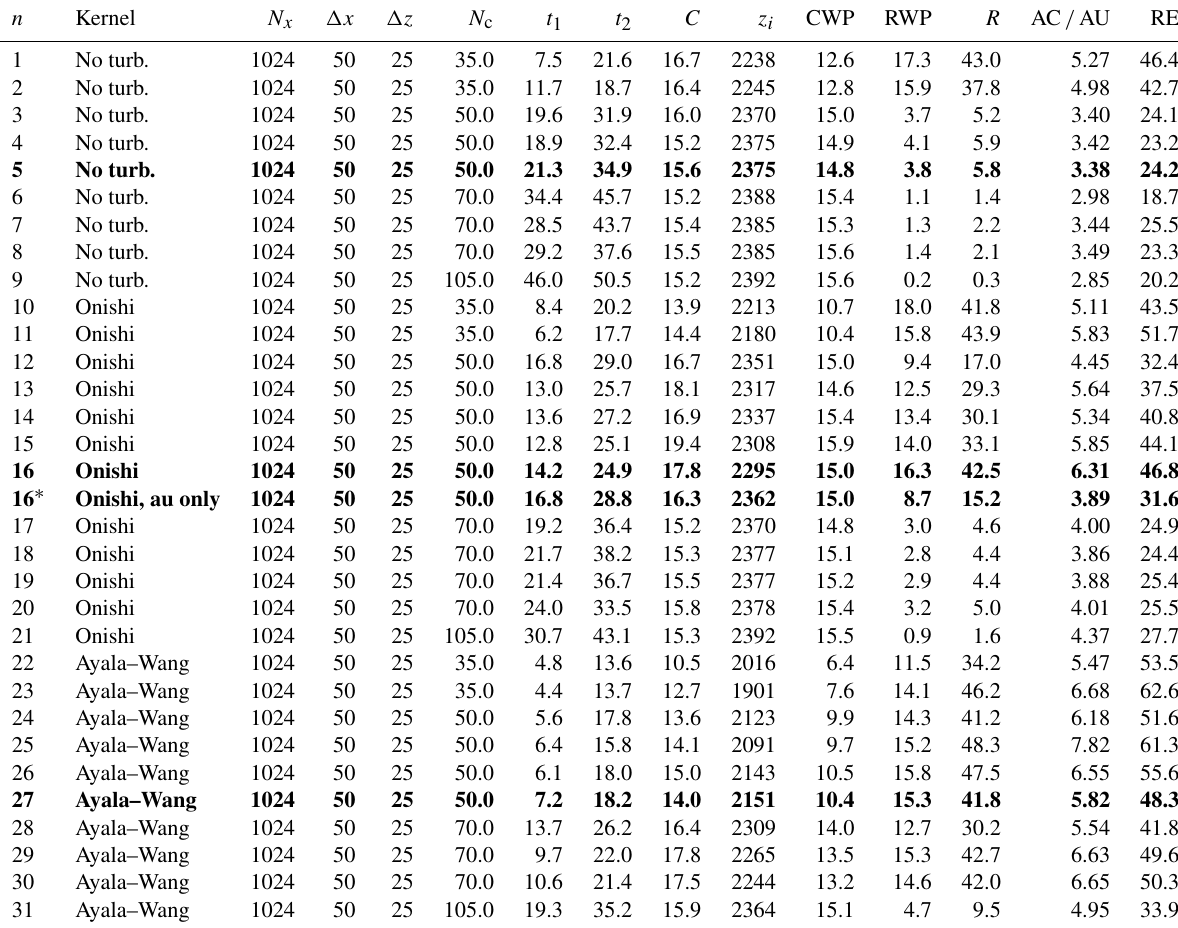
Table 2. Statistics for the large-eddy simulations assuming different collection kernel. N x is the number of grid points in the horizontal, and (cid:49)x and (cid:49)z are the horizontal and vertical grid spacing. Listed variables are the timescales t 1 and t 2 , which characterize the transition to precipitating shallow convection (0.1mmday − 1 as rain rate threshold for t 1 , 0.8mmday − 1 for t 2 ), the area-averaged cloud cover C , the inversion height z i , cloud liquid water path (CWP) in gm − 2 , rainwater path (RWP) in gm − 2 , surface rain rate R in Wm − 2 (29Wm − 2 corresponds to mmday − 1 ). The ratio of accretion over autoconversion, AC / AU, and the rain efficiency, RE = 1 − EV /( AU + AC ) (both evaluated over the whole column). Time averages are from 24 to 30h. The simulations shown in Fig. 5 are indicated by bold font. Simulations with identical model configuration (kernel, N x , (cid:49)x , (cid:49)z , N c ) differ only by the random seed of the initial